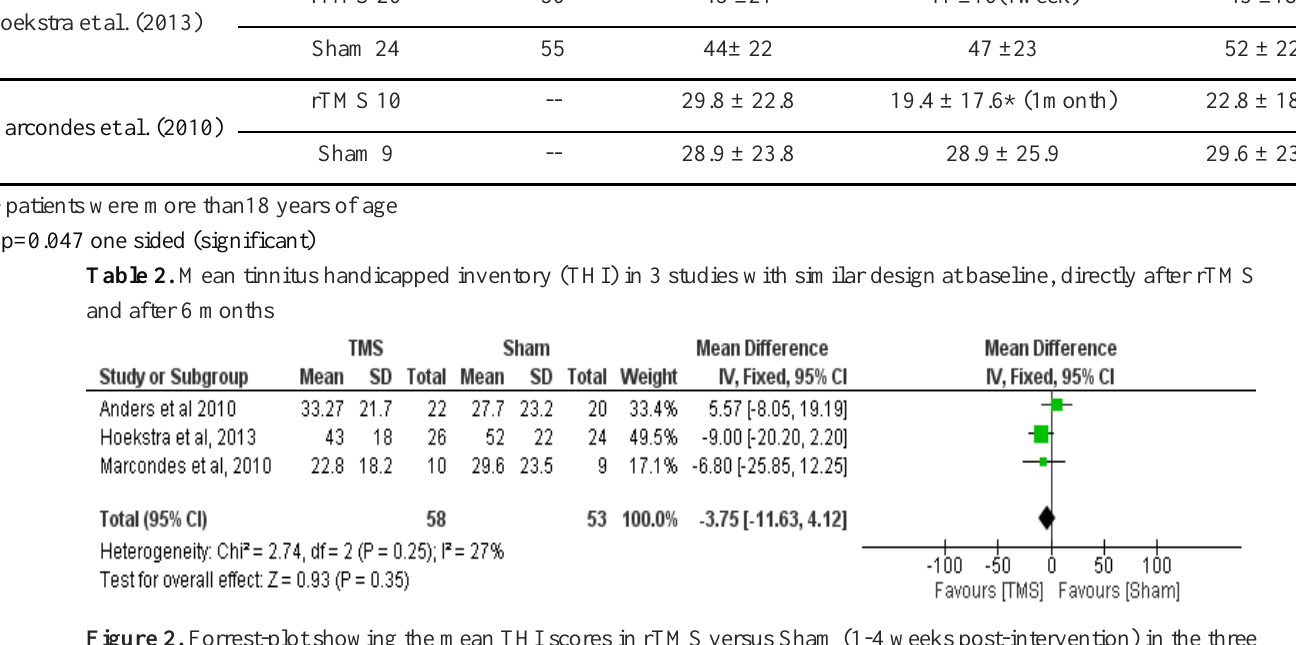
Figure 2. Forrest-plot showing the mean THI scores in rTMS versus Sham (1-4 weeks post-intervention) in the three